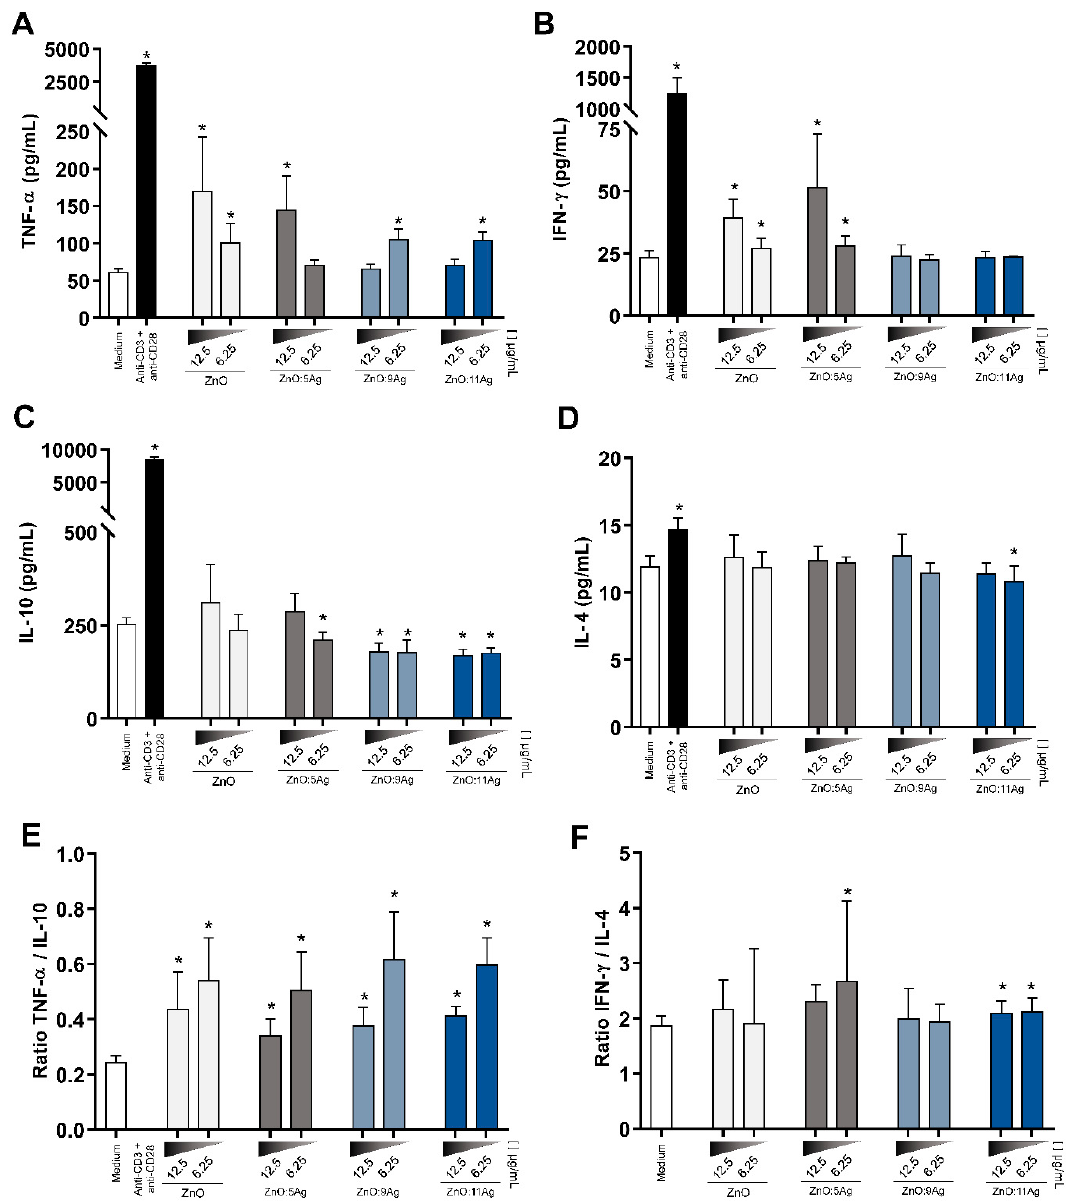
Figure 7. Cytokine production by treated PBMCs. The levels of TNF- α , IL-10, IFN- γ and IL-4 were evaluated by ELISA in the supernatant of cultures of PBMCs treated with different nanoformulations at doses of 12.5 µ g/mL and 6.25 µ g/mL for 72 h. The results are expressed as the mean ± SEM in picograms per milliliter (pg/mL). The Mann–Whitney test was applied, and values of p < 0.05 (*) were considered significant when compared to cell culture without treatment (medium). Cells without treatment (medium) and cells treated with anti-CD3 and anti-CD28 stimuli were used as negative and positive controls, respectively. ( A ) TNF- α levels were increased when treated with ZnO nanocrystals, ZnO:9Ag and ZnO:11Ag NCPs at the two doses tested, as well as treatment with ZnO:5Ag at 12.5 μ g/mL. ( B ) The level of IFN- γ was upregulated in ZnO nanocrystals and ZnO:9Ag NCPs at both doses. ( C ) IL-10 quantification was lower in the treatment with ZnO:5Ag NCPs at 6.25 μ g/mL and in both doses in the treatment with ZnO:9Ag and ZnO:11Ag NCPs. ( D ) For IL-4, only ZnO:11Ag NCPs at 6.25 μ g/mL decreased the production of this cytokine. ( E ) All nanomaterials had increased levels of TNF- α compared to IL-10 levels. ( F ) ZnO:5Ag at 6.25 μ g/mL and ZnO:11Ag (two doses tested) positively regulated IFN- γ levels when compared with IL-4 levels.